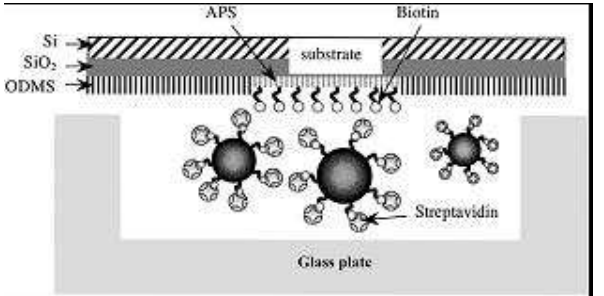
Figure 9. Schematic illustration of biotin-streptavidin reaction on a SAM-modified substrate. Biotin is attached to the aminopropyl silane (APS) patterned substrate. Streptavidin-modified magnetic microbeads are injected into a channel on a glass plate. The magnetic beads are bound by a specific interaction between biotin and streptavidin ( Reprinted from [25] with permission from Wiley-VCH ).